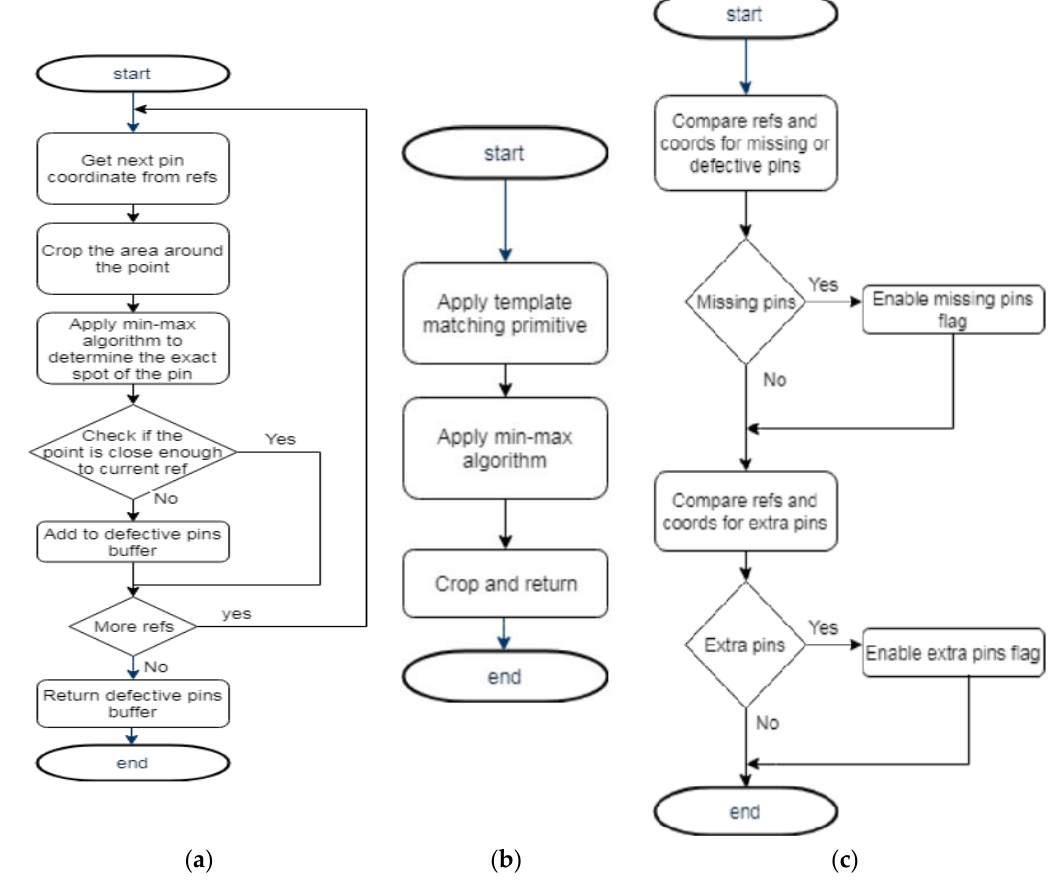
Figure 12. Flowchart of the function ( a ) referencedTemplateMatch; ( b ) findBest; ( c ) compare.